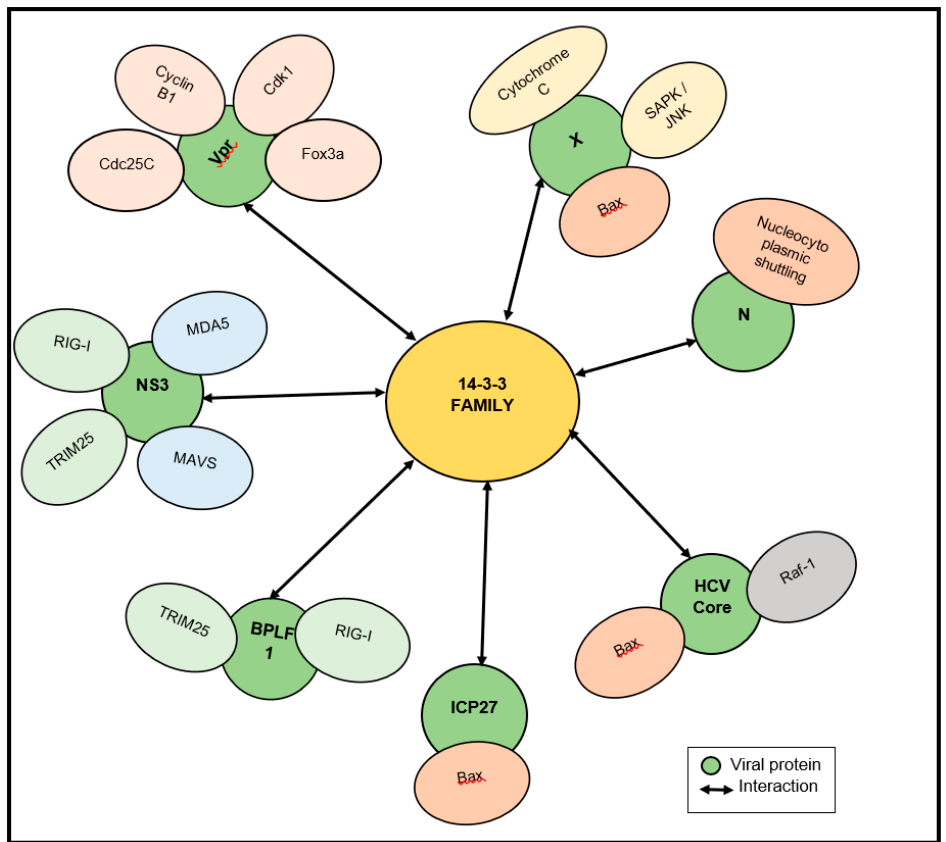
Figure 3. Schematic illustration of the signaling pathways which are manipulated by virus–14-3-3 interactions. Yellow nodes indicate the 14-3-3 family, green nodes indicate the viral proteins and other nodes indicate the functional proteins in signaling pathways.